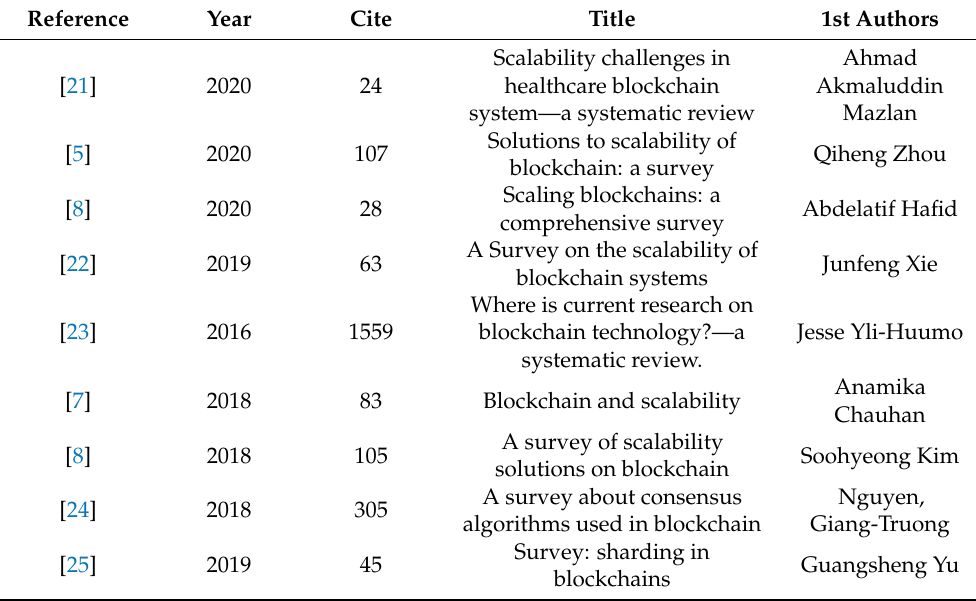
Table 1. Some recent survey and review articles on blockchain